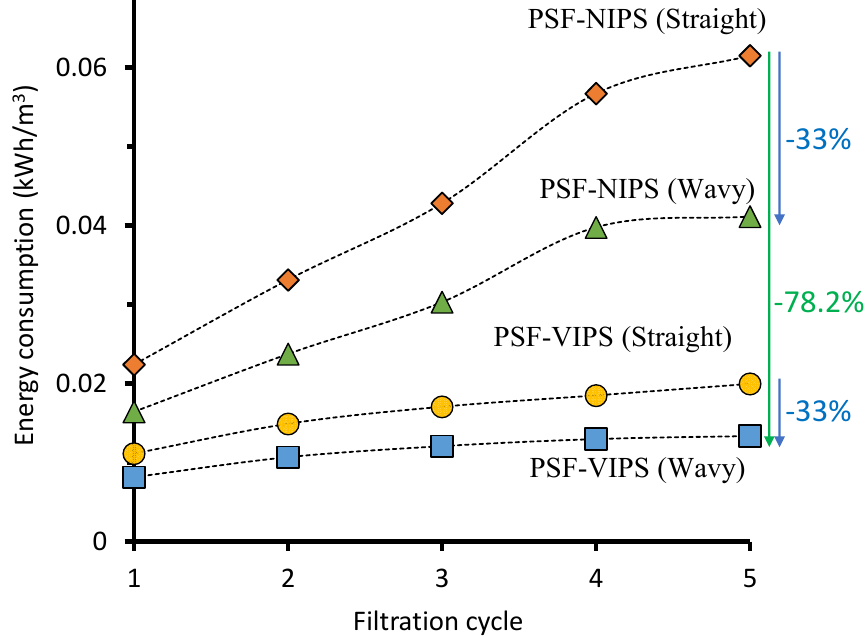
Figure 4. Pumping energy footprint reduction through the membrane and the flow channel development for oil/water emulsion treatment.